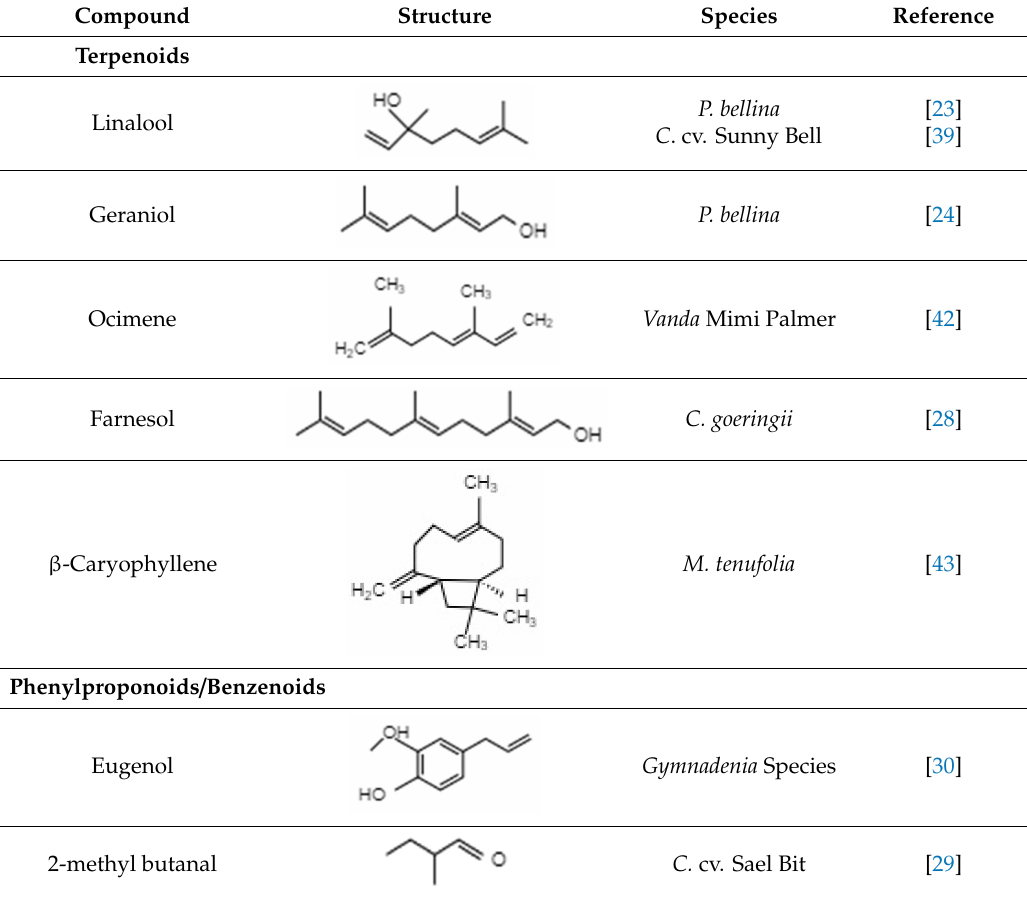
Table 1. Major volatile organic components in orchid flowers.